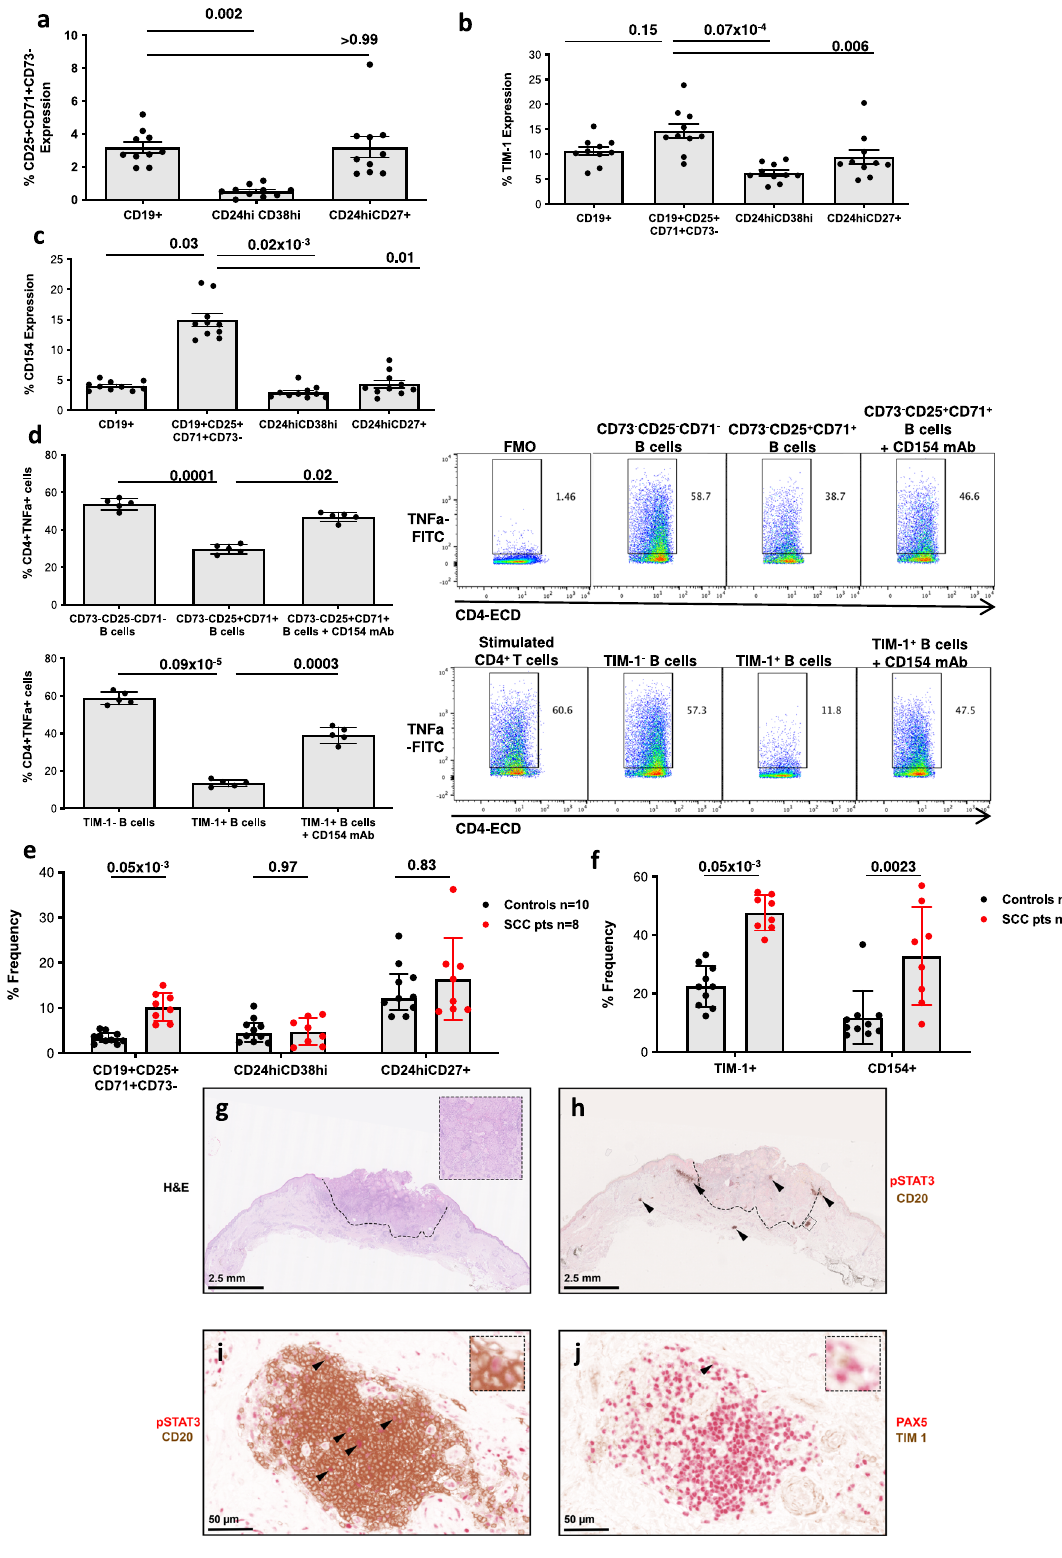
To assess the effect of expBreg on intracellular cytokine production by CD4 + T cells, expBreg cells were co-cultured with CD4 + T cells and anti-CD3/CD28 beads for 72h. 2% PMA, 1% ionomycin and 1% brefeldin (PIB) were added to cultures for the last 6h of culture; cells were then harvested, surface-stained, permeabilised and stained intracellularly for Th1 cytokines interferon- γ (IFN γ ) and tumour necrosis factor α (TNF α ). In some experiments, non-expanded CD19 + B cells were co-